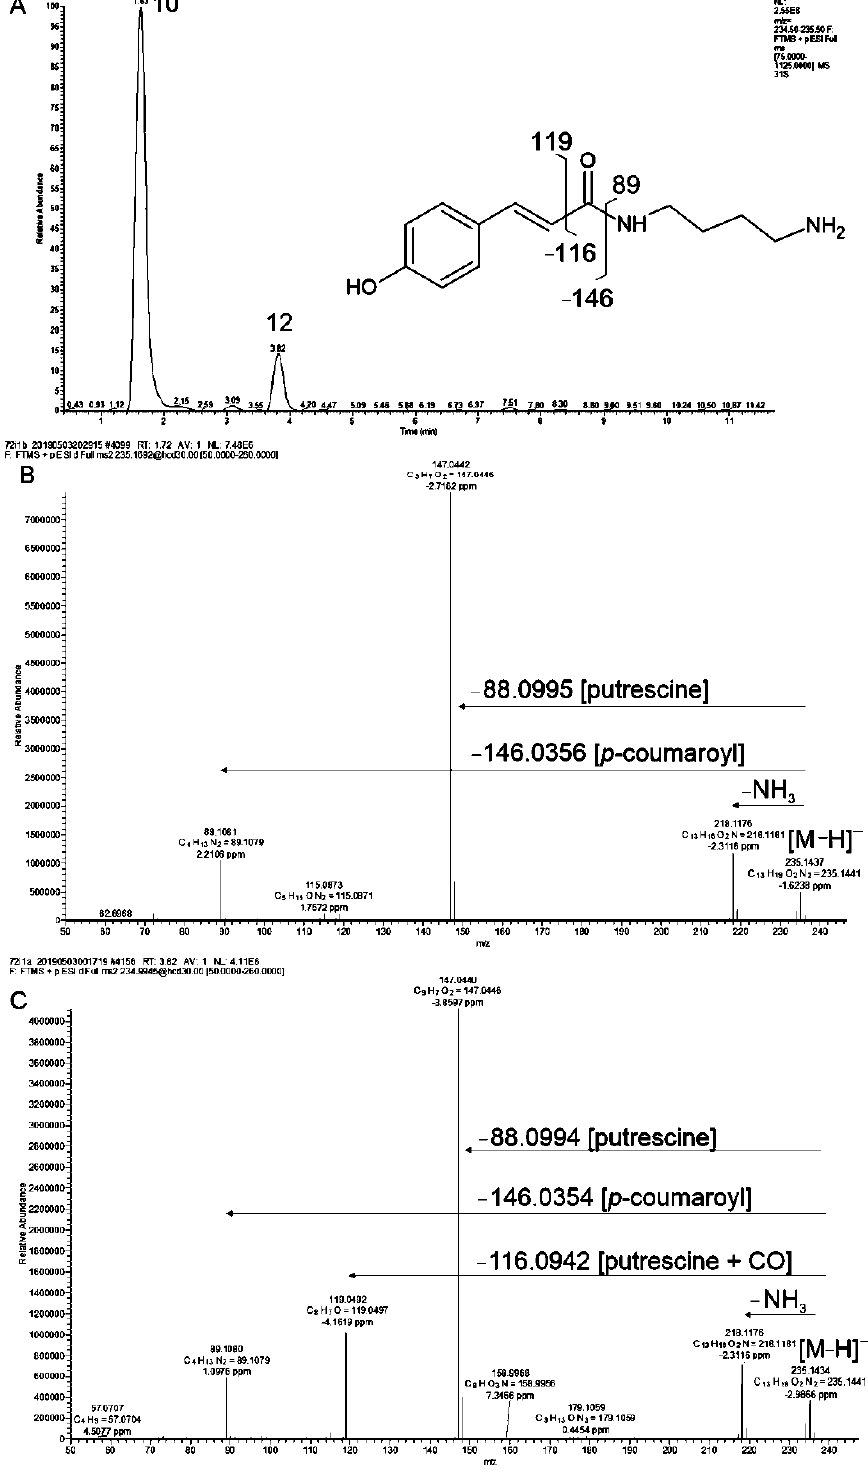
Figure 6. Representative chromatogram ( A ) and high-resolution MS/MS spectra obtained in positive ionization of two isomeric structures of p -coumaroyl- N -putrescine ( B ) compound 10 and ( C ) compound 12 . Postulated structure and proposed simplified fragmentation schemes are shown.